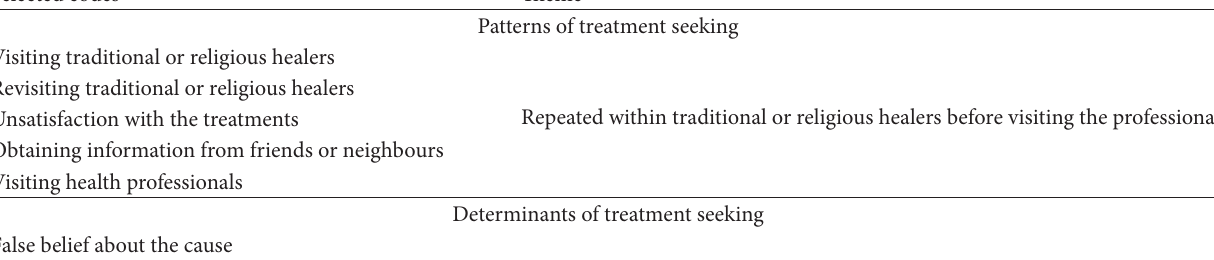
Table 1: Selected codes and categories that emerged while exploring the patterns and determinants of treatment seeking. Selected